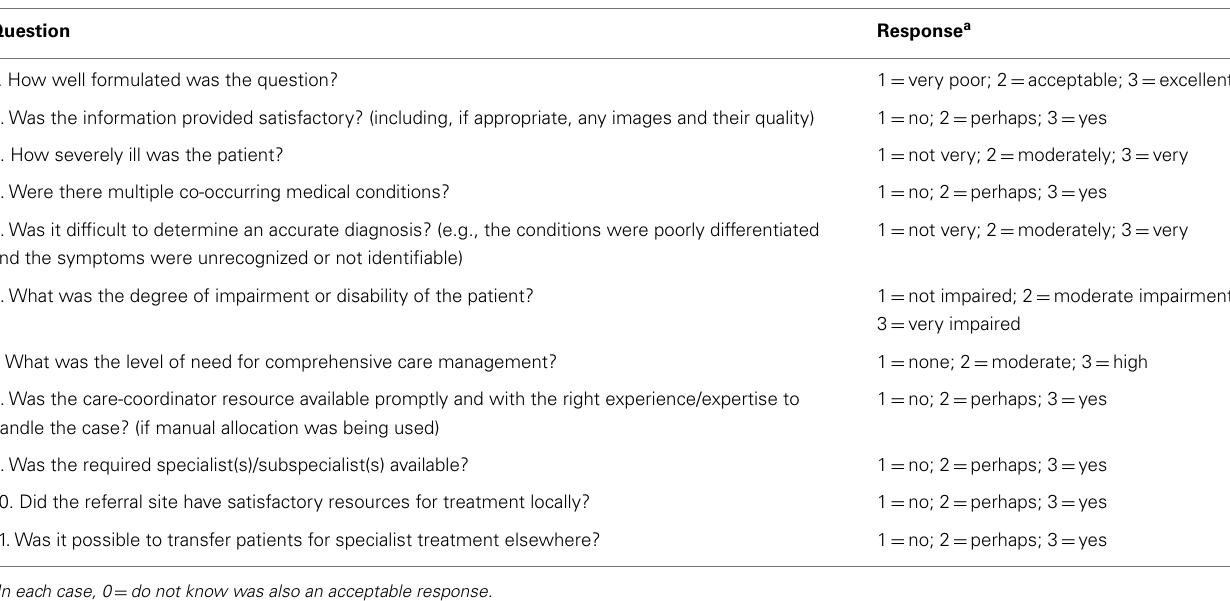
Table 3 | Direct assessment of case difficulty .